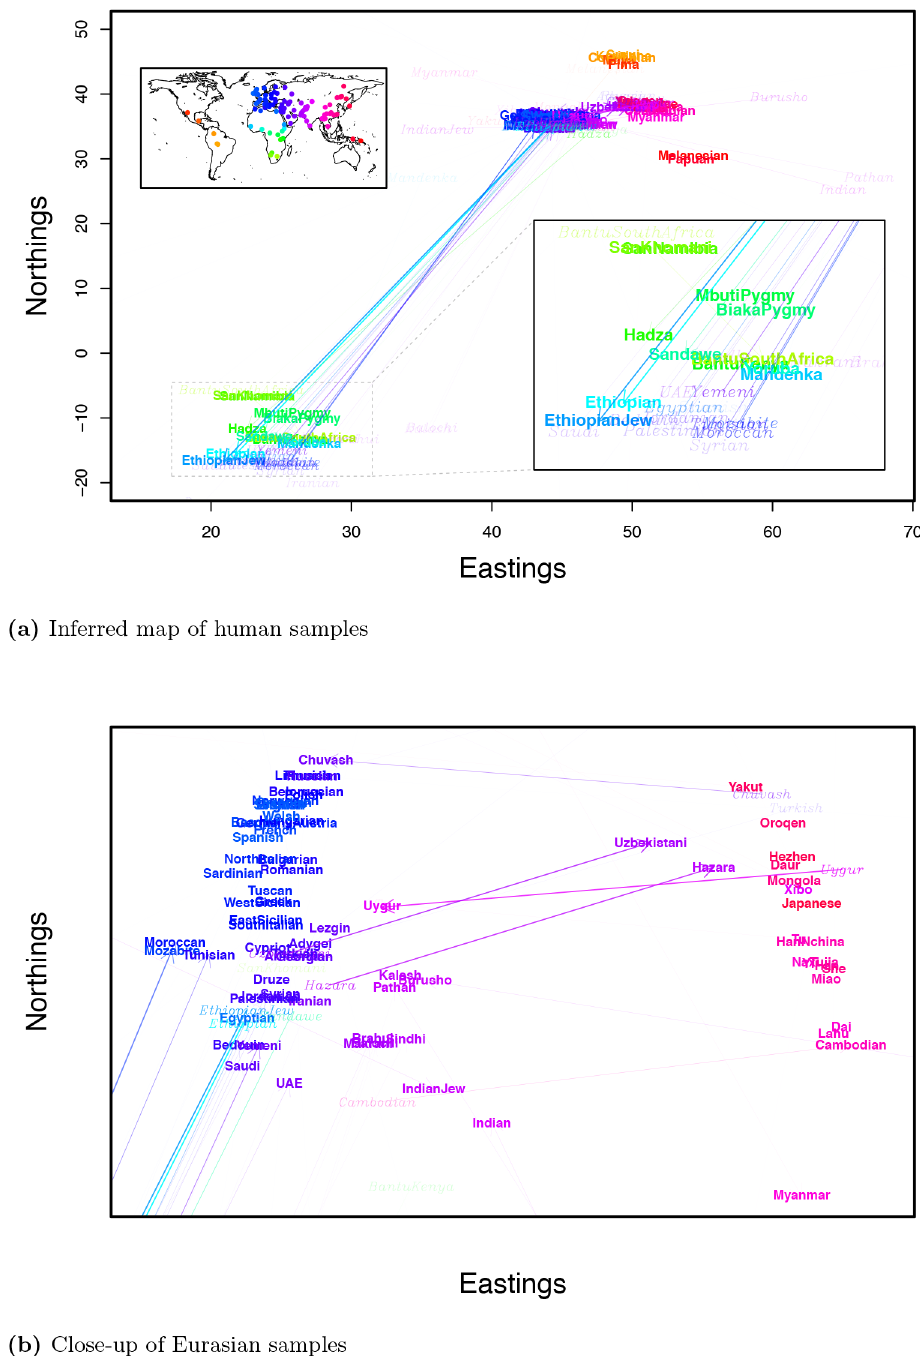
Fig 9. Geogenetic map of human samples, inferred with admixture. Labels are colored as in as in Fig 5b. Italicized labels denote locations of admixture sources, with opacity proportional to the amount of admixture drawn by the sample. a) complete map; b) close-up of Eurasian